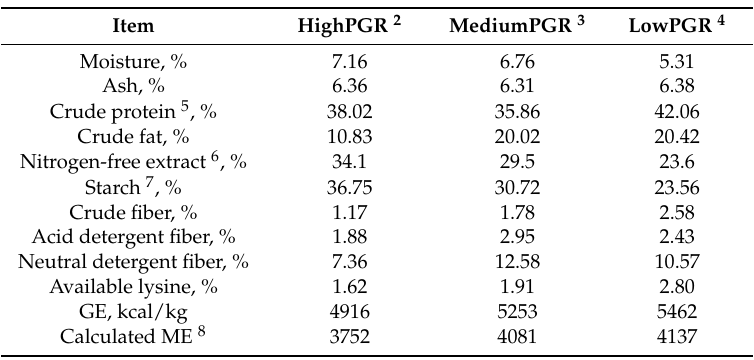
Table 1. Analyzed nutrient composition of the 3 experimental diets differing in perceived glycemic response (PGR) 1 .